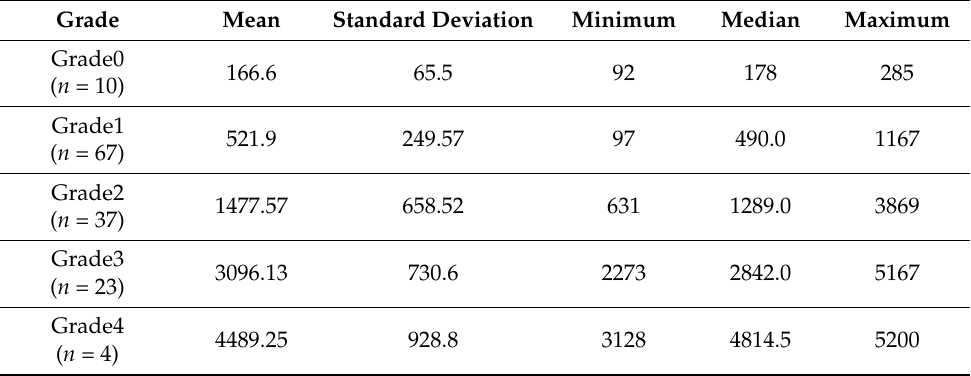
Table 1. Numerical summaries of total inflammatory cell count according to examiner1’s manual endometritis grades.